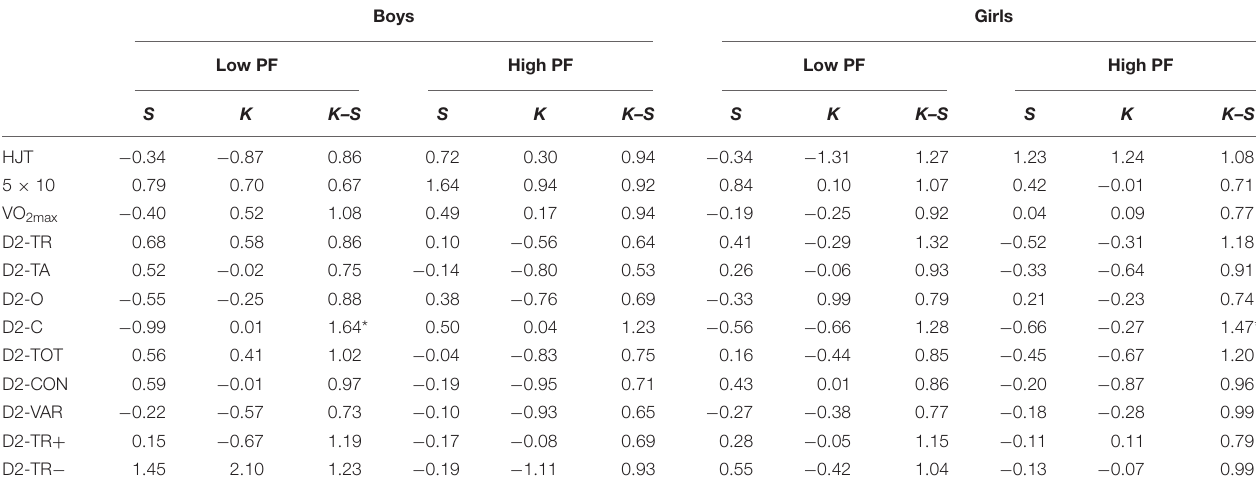
TABLE 5 | Skewness, Kurtosis and Kolmogorov–Smirnov by cluster and gender. Boys